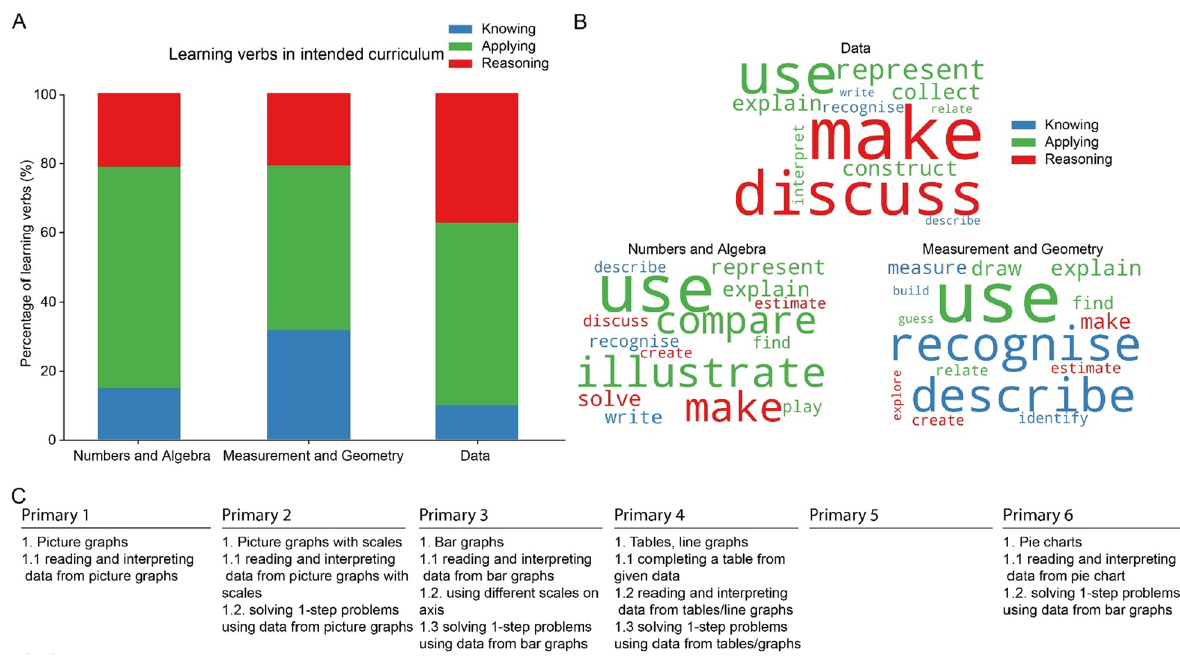
Fig. 2 Comparing mathematics content domains in the intended curriculum in Singapore. A Cognitive domains of learning verbs used in different content domains in the intended mathematics curriculum combined across all levels. B Word cloud of learning verbs as a function of content domains with size related to the frequency of word occurrence within a content domain and colors corresponding to cognitive domains. C Progression of contents in the data